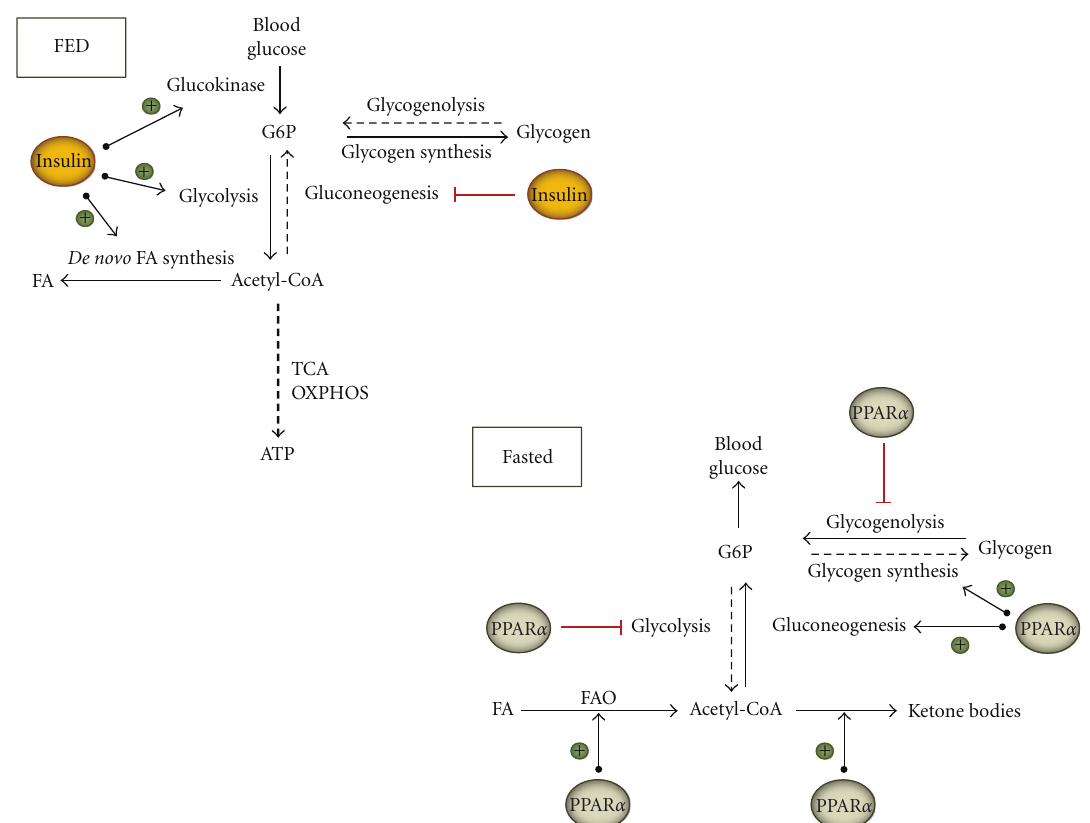
Figure 1: Influence of insulin and PPAR α on carbohydrate metabolic pathways. Di ff erent fates and di ff erent sources of hepatic G6P are depicted, together with the regulatory e ff ects of PPAR α . FA: fatty acids; FAO: fatty acid oxidation; G6P: glucose-6-phosphate; OXPHOS: oxidative phosphorylation; TCA: tricyclic acid